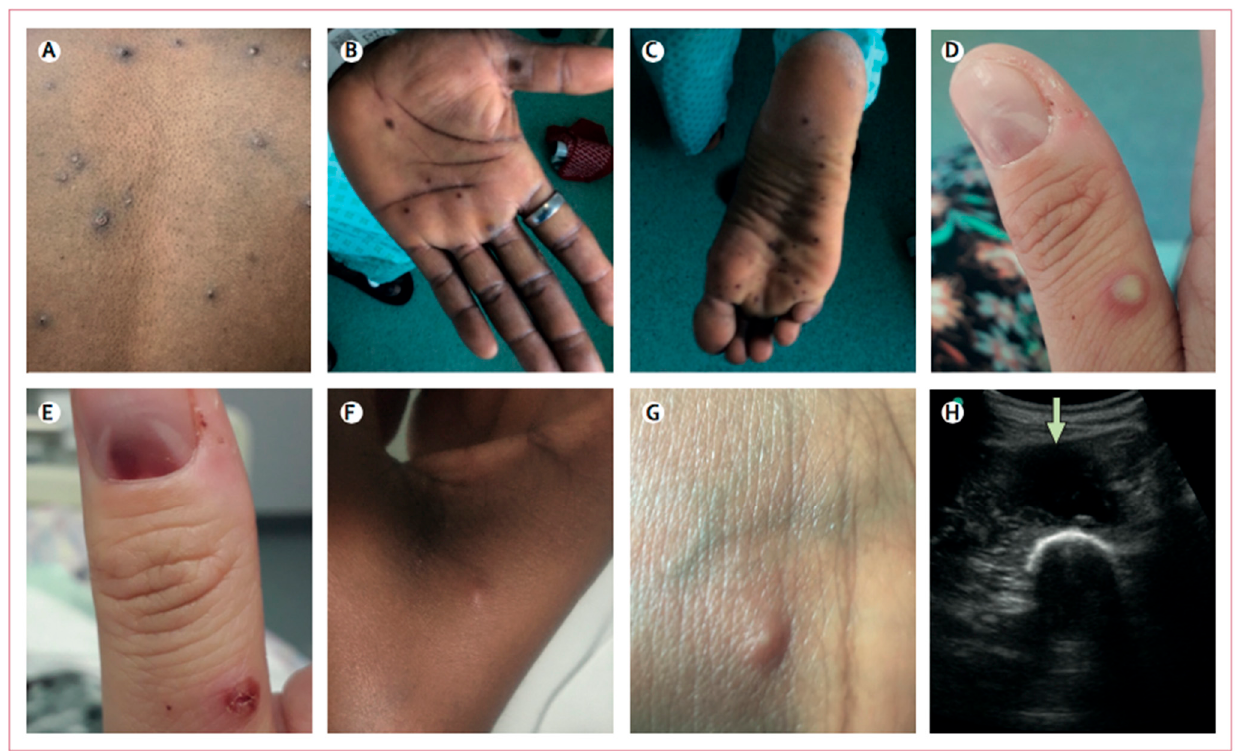
Figure 2. Skin and soft tissue manifestations of monkeypox. Skin and soft tissue features included: ( A , D ) vesicular or pustular lesions; ( B , C ) macular lesions involving the palms and soles; ( D , E ) a sub-ungual lesion; ( F , G ) more subtle papules and smaller vesicles; ( H ) and a deep abscess (arrow, image obtained during ultrasound-guided drainage). From: Adler H, Wingfield T, Price NM: Clinical Features and Management of Human Monkeypox: A Retrospective Observational Study, in the UK Lancet Infect Dis 2022; 22: 1153-62. Copyright 2022 by Elsevier. License number for the reuse of this figure: 5414980739216.